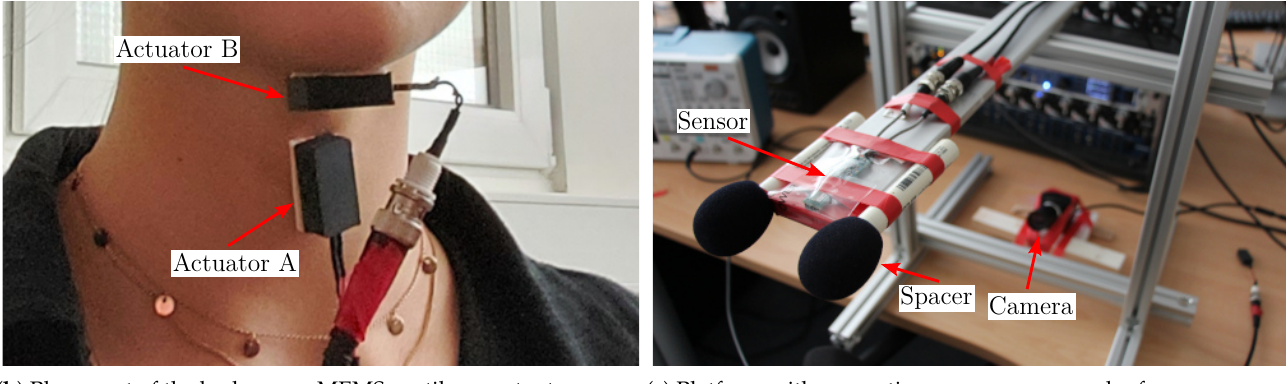
Figure 2. Overview of the experimental setup for magnetic swallowing